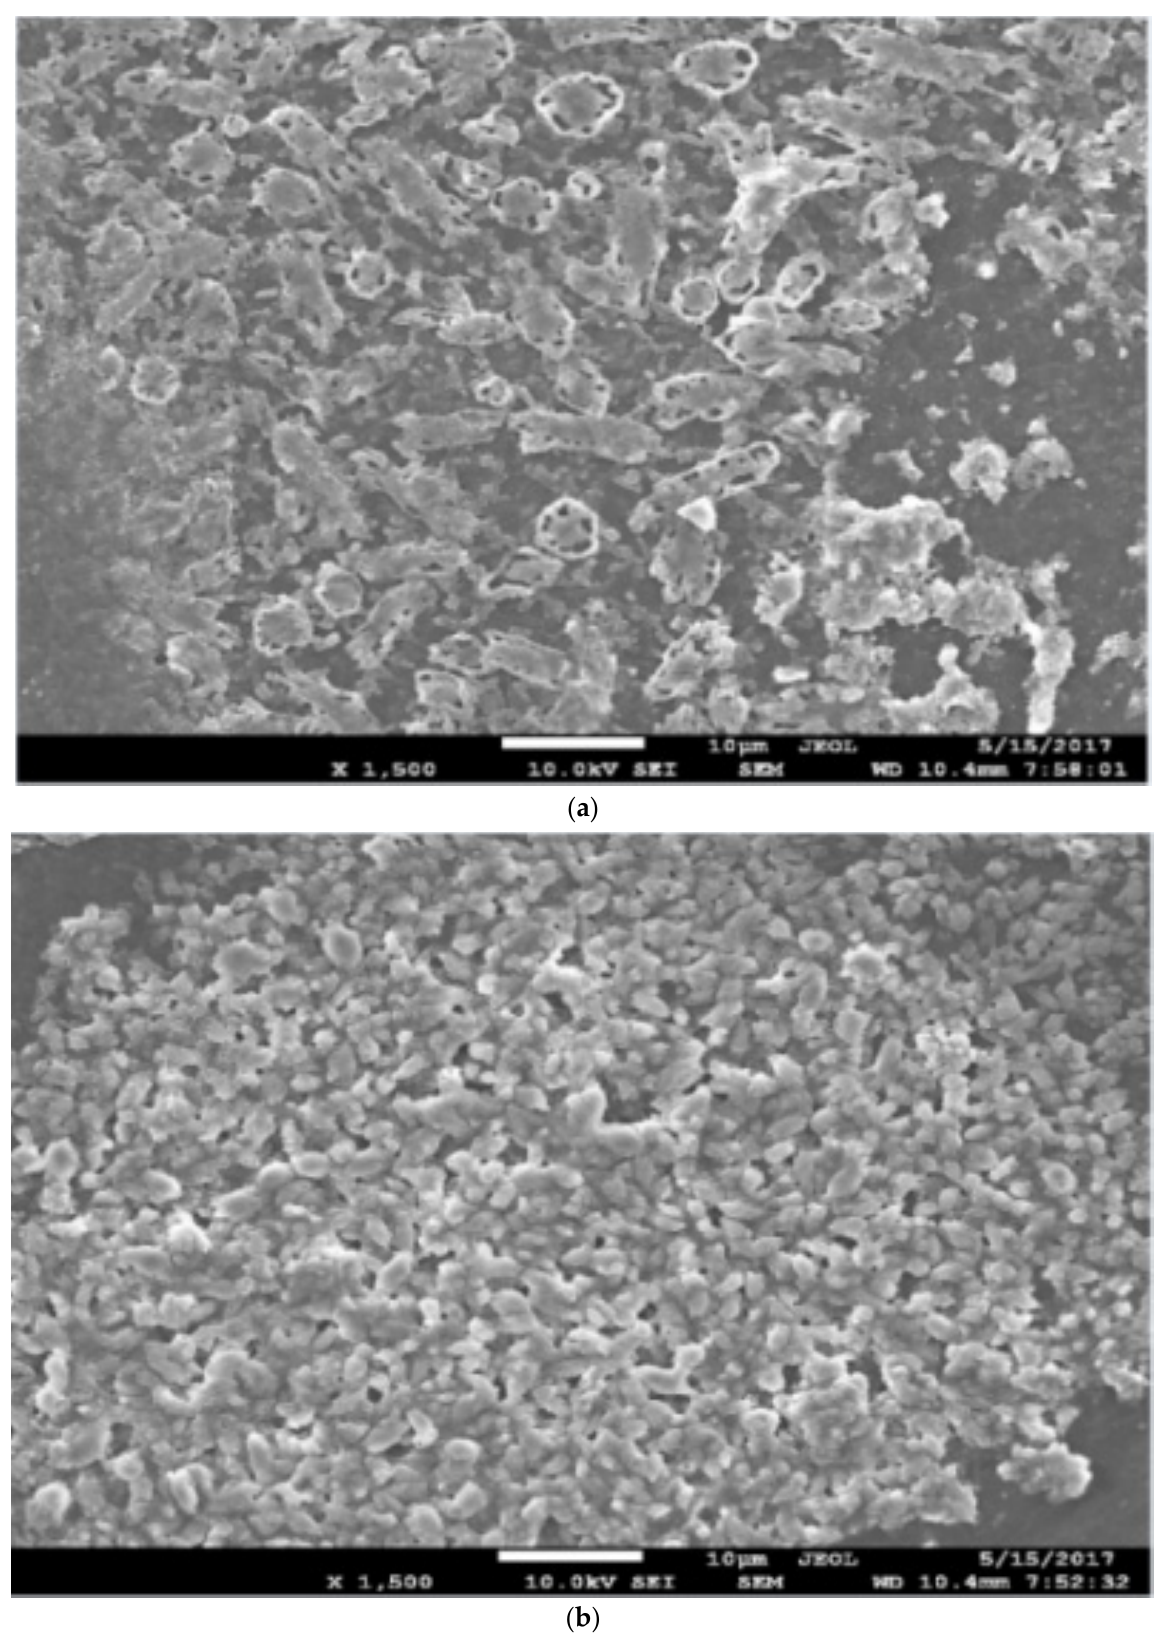
Figure 3. ( a ) SEM image of biofilm at the top; ( b ) SEM image of biofilm at the